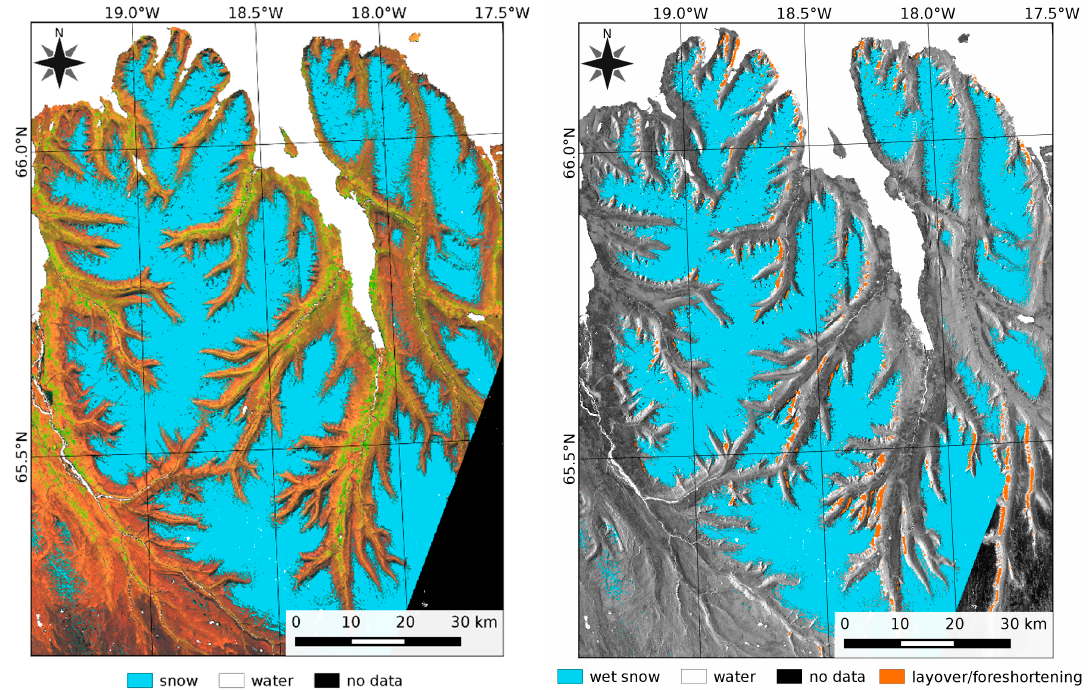
Figure 3. Snow map of Tröllaskagi Peninsula, Iceland. ( Left ) Snow extent (blue) derived from Landsat-8 image of 27 June 2015; white: water; background: Landsat-8 OLI bands 6, 5, 4. ( Right ) Wet snow extent (blue) derived from Sentinel-1 image of 26 June 2015; background: S1 amplitude image, VV -channel; orange: mask for layover and foreshortening.